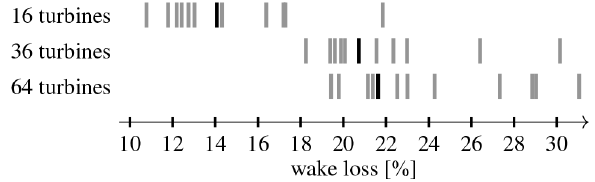
Figure 13. Comparison of IEA Wind Task 37 Case Study 1 wake loss percentages. Black bars show the results of the case studies discussed here.